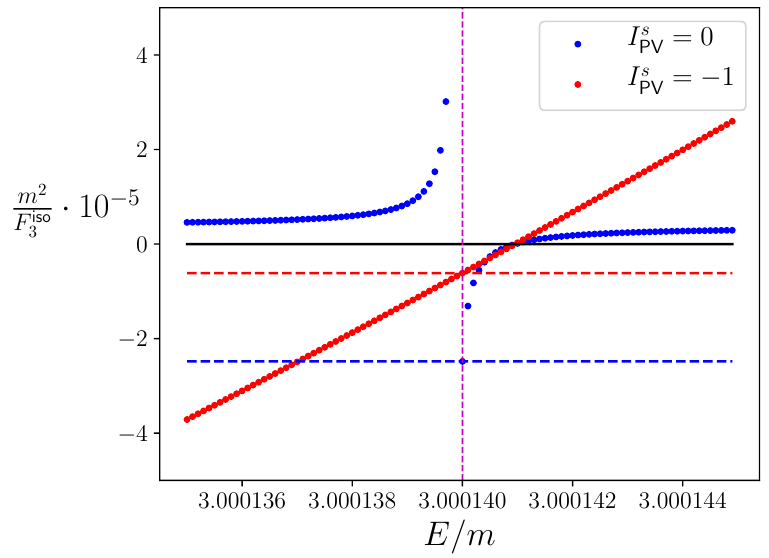
Figure 13 . Determining the I s dependence of K df ; 3 in the isotropic approximation using the PV ground-state energy, E 0 , for ma 0 = 0 : 1 and mL = 30. Blue and red points show m 2 =F iso for, 3 I s = 0 and (cid:0) 1, respectively. The vertical purple dashed line shows our chosen tuning energy, PV while the horizontal dashed curves show the resulting values of (cid:0)K iso df ; 3